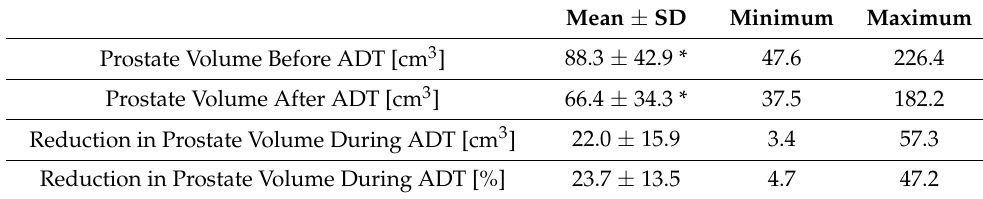
Table 2. Volume of Prostate [cm 3 ].